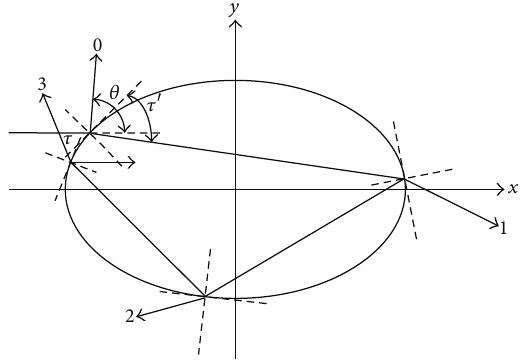
Figure 1: Geometric optical scattering by elliptical